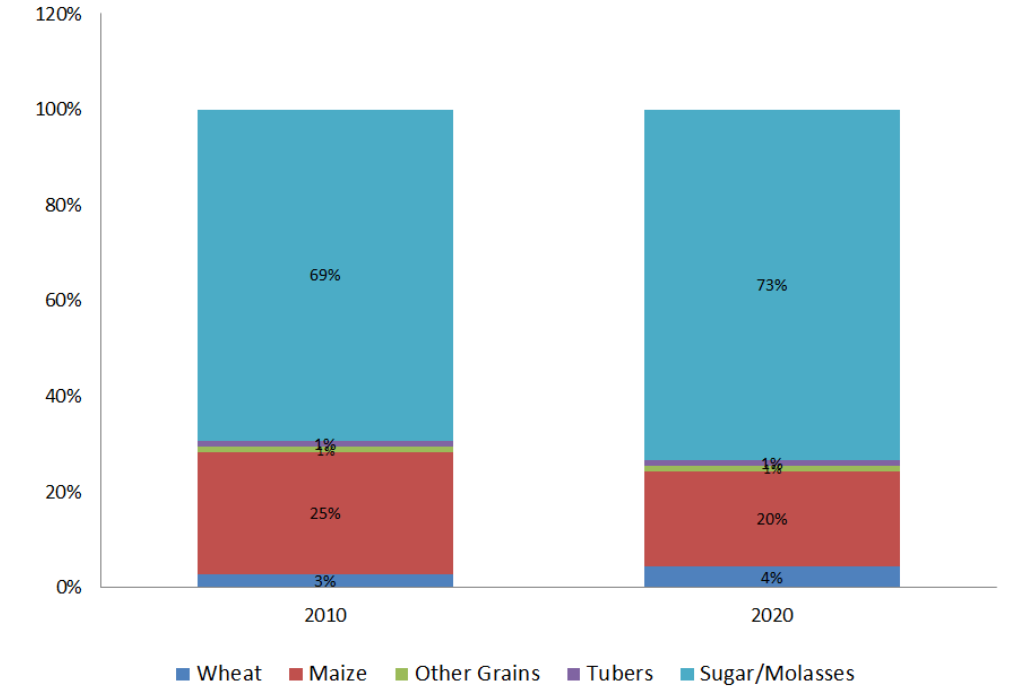
Figure 6. Share of total feedstock tonnage used in global ethanol production from various